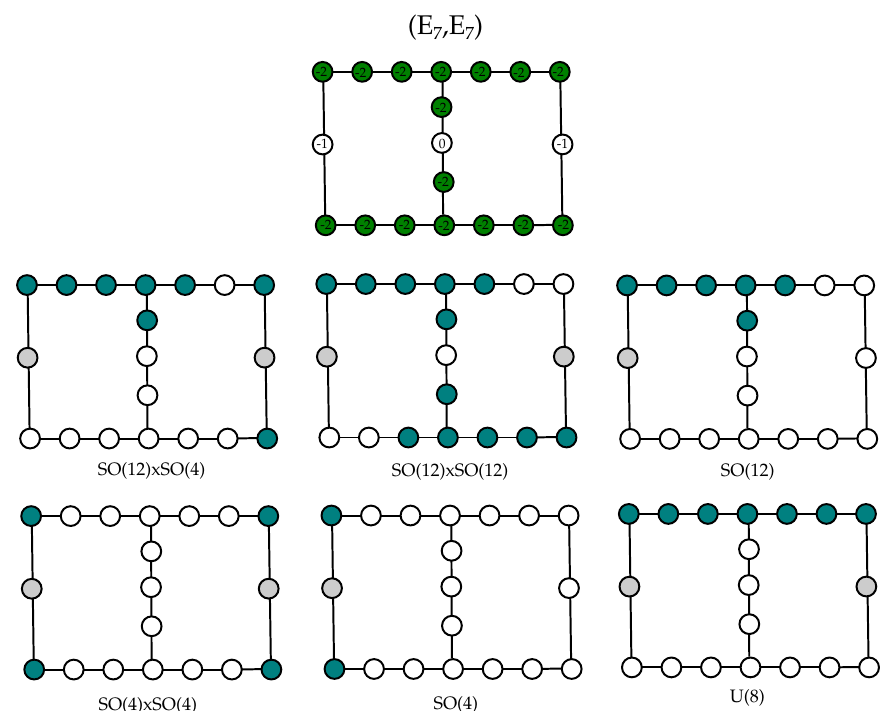
Figure 16. Embedding of potential BG-CFDs into the ( E 7 ; E 7 ) Marginal